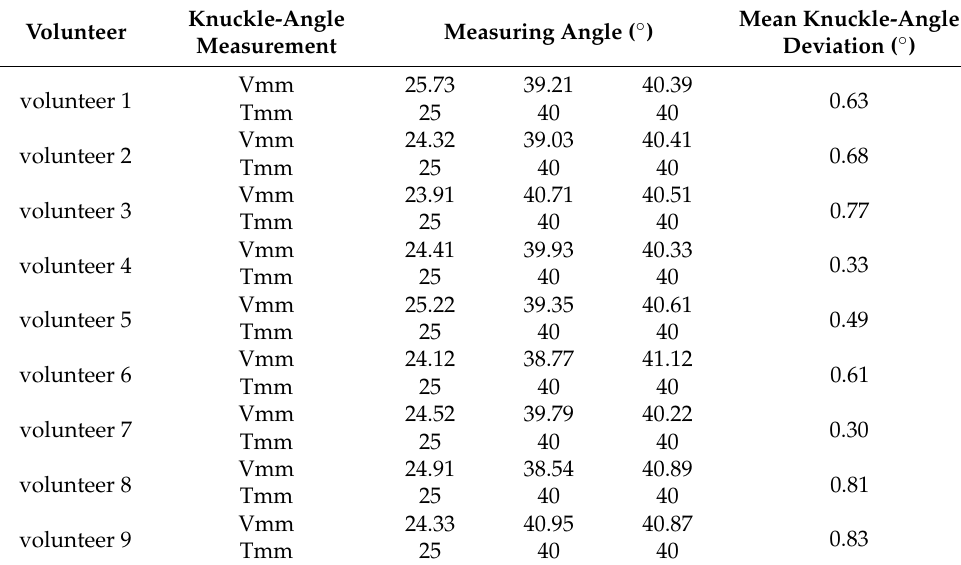
Figure 11. Deviation from the mean value of knuckle angle at different scales. Table 4. Measurement results of abduction/adduction knuckle angle.